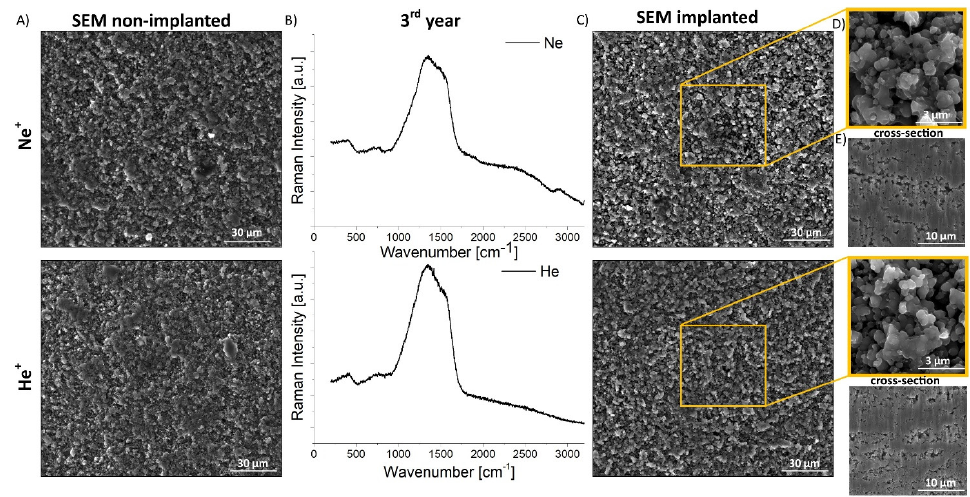
Figure 6. ( A ) SEM images of non-implanted surface of S-3 particle, ( B ) Raman spectra obtained for the Ne + and He + implanted samples with the fluence equivalent to 3 years of irradiation, ( C ) SEM images of implanted S-3 samples—3rd year of implantation with Ne + and He + ions; ( D ) SEM magnification of selected region; ( E ) the cross-section of S-3 implanted sample.